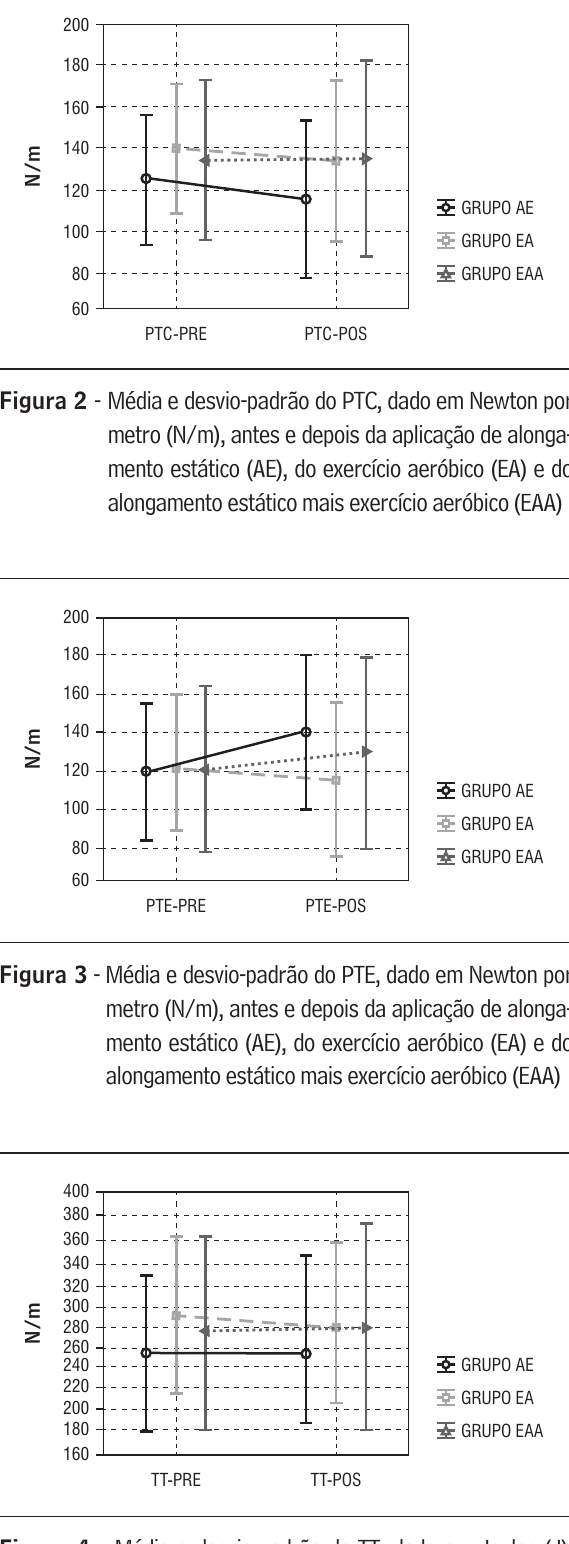
Figura 4 - Média e desvio-padrão do TT, dado em Joules (J), antes e depois da aplicação de alongamento estático (AE), do exercício aeróbico (EA) e do alongamento estático mais exercício aeróbico Fisioter Mov. 2011